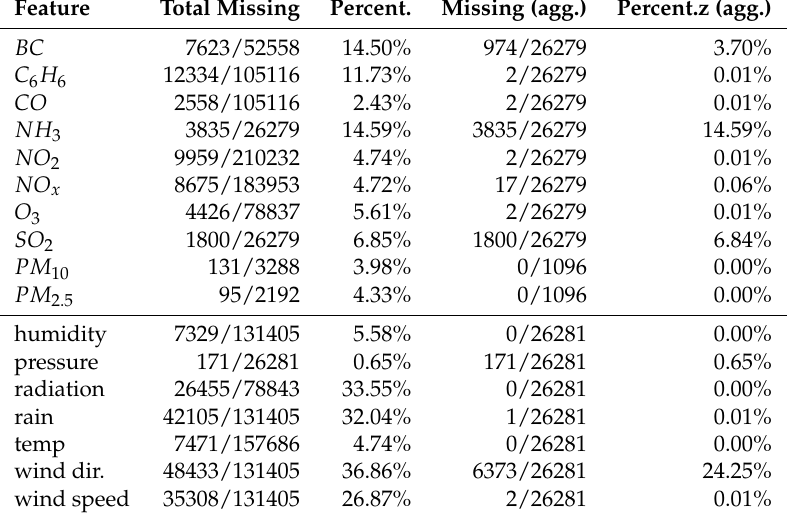
Table 2. Total amount of missing values for weather and pollutant sensors. On the left, the count represents the amount w.r.t. total feature values, on the right, the result after mean aggregation among groups.